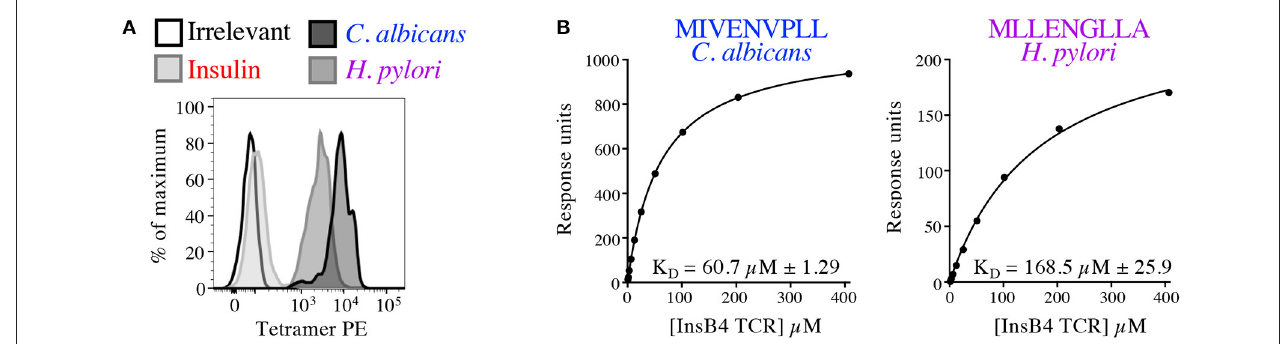
FIGURE 10 | Pathogen-derived peptide ligands bind to the InsB4 TCR. (A) Optimised pMHC tetramer staining of the InsB4 T-cell clone with HLA A2-HLVEALYLV (insulin), HLA A2-MLLENGLLA ( H. pylori ) and HLA A2-MIVENVPLL ( C. albicans ) epitopes. (B) SPR binding data of the interaction between the InsB4 TCR and HLA A2-MIVENVPLL and HLA A2-MLLENGLLA. Binding with the index HLA A2-HLVEALYLV peptide was too weak to